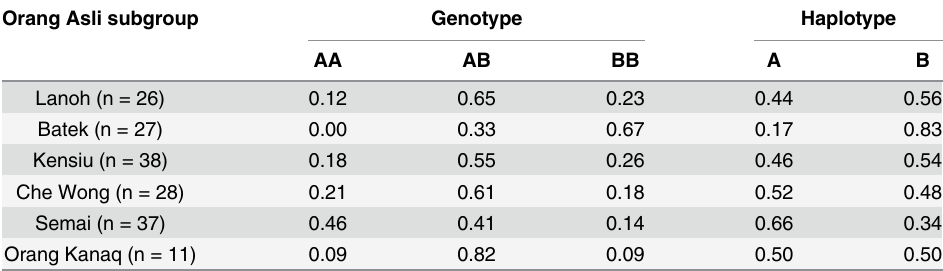
Semai (n = 37) Orang Kanaq (n = 11) 0.50 The prediction of AA , AB and BB genotypes following Rajalingam et al. [21]. Haplotypes frequencies are calculated using the standard formula (see Materials and